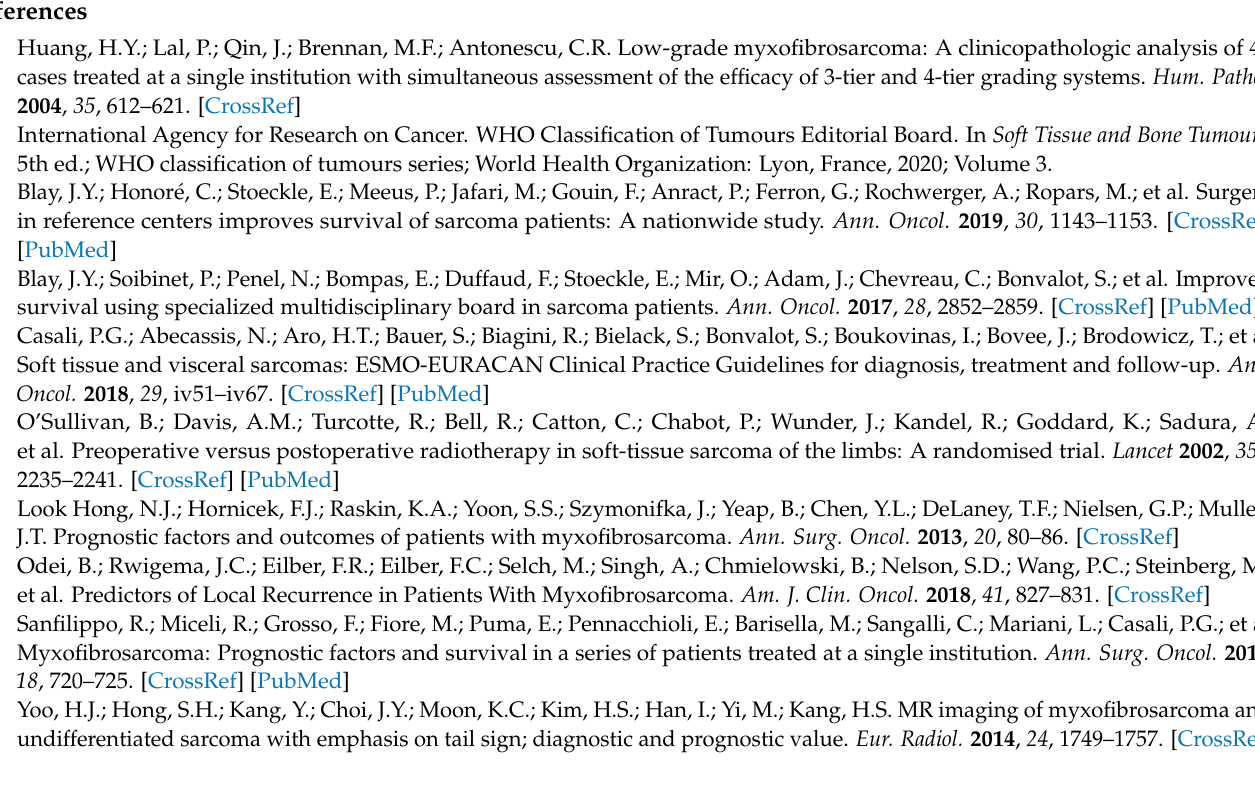
Protocol S1: Objective immuno-histochemistry scoring method (Figures S1–S5). Figure S6: An Figure S7: A grade 2 MFS tumor lo-cated in the upper arm of a 63-year-old female. Figure S8: A grade 3 MFS tumor located in the upper arm of a 64-year-old